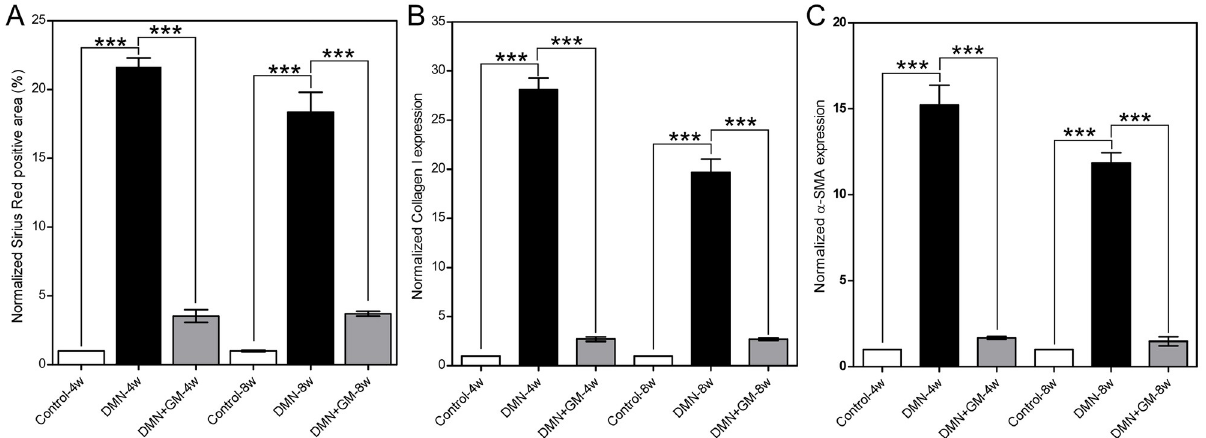
Fig 3. The effects of GM-CSF on DMN-induced histopathological changes. ( A ) Sirius Red staining, ( B ) collagen type I content, and ( C ) α -SMA expression. Data were calculated from liver tissue sections (Figs 2 and 3 ). Colors corresponding to Sirius Red, collagen type I, and α -SMA for each rat were separated by deconvolution, and color intensities corresponding to Sirius Red, collagen type I, and α -SMA were measured. Results were averaged and normalized with respect to the corresponding control groups and are presented as fold-changes, expressed as means ( ± SEM) was significantly different between the control and DMN-treated groups and between the DMN-treated groups and DMN+GM-CSF groups ( ��� p � 0.001).